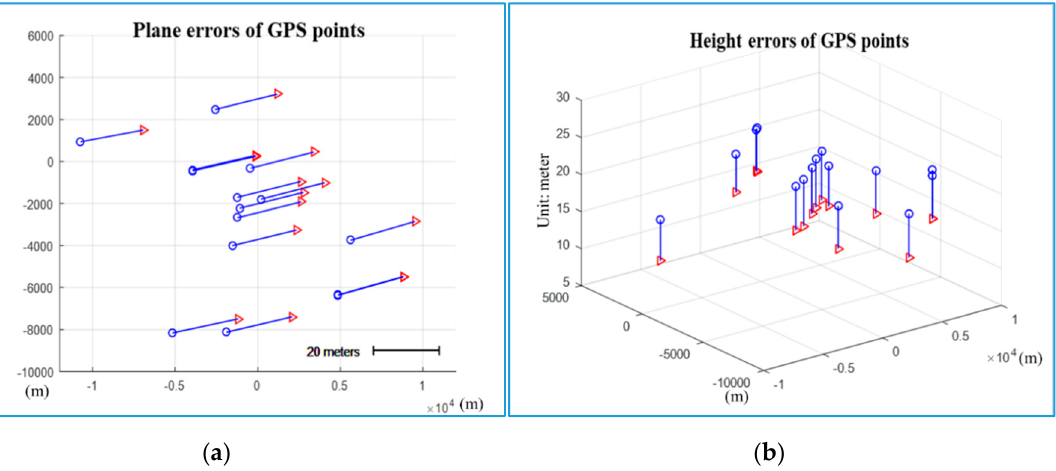
Figure 7. Deviations in GPS checkpoints. Displayed are ( a ) the horizontal and ( b ) the vertical di ff erences between measured GPS coordinates and coordinates reconstructed from the KOMPSAT image pair (circles: reconstructed positions; triangles: GPS positions).